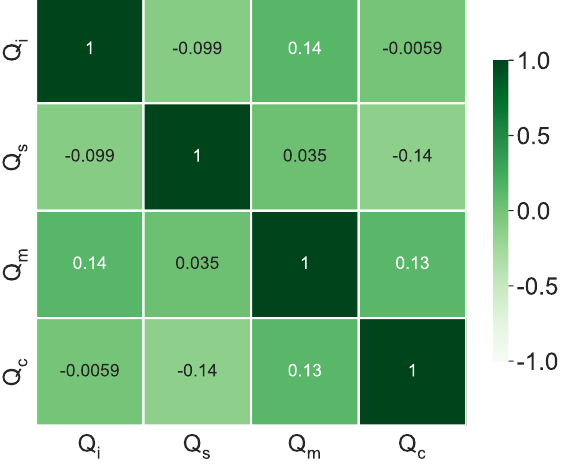
Figure 7. Input correlation